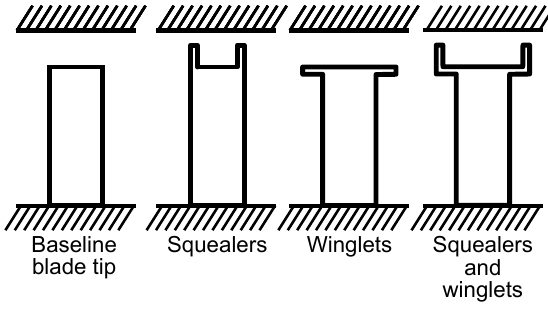
Figure 8. Schematic view of squealer and winglet